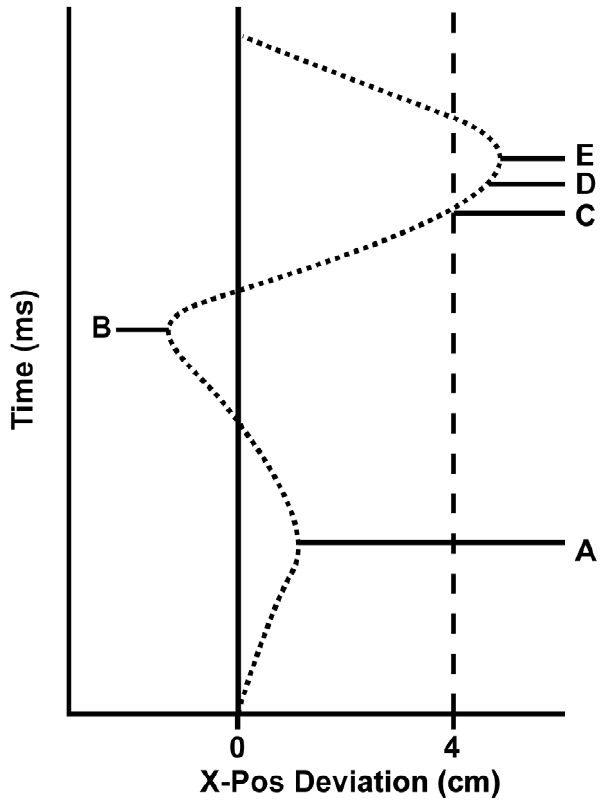
Figure 2. Typical x-axis response curve for leaning to the right (schematic) showing the response onset (time A), the response push-off (time B), the response threshold (time C), the response cut-off 500 ms after the threshold has been exceeded (time D), and the maximum response amplitude (time E).